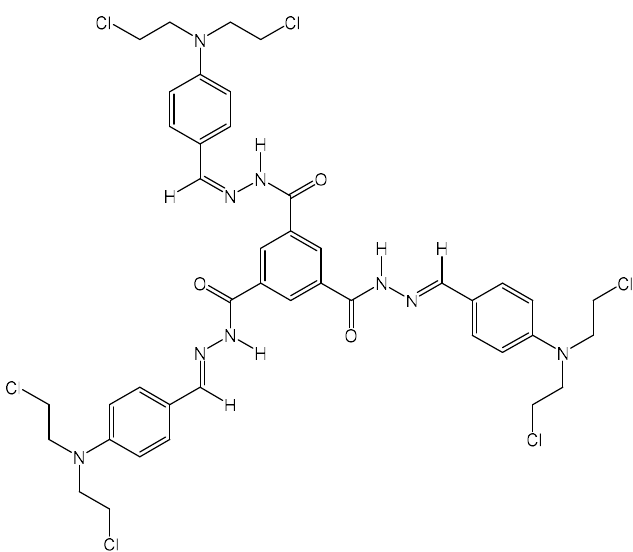
Figure 6. Structural representation of the tripodal nitrogen mustard.